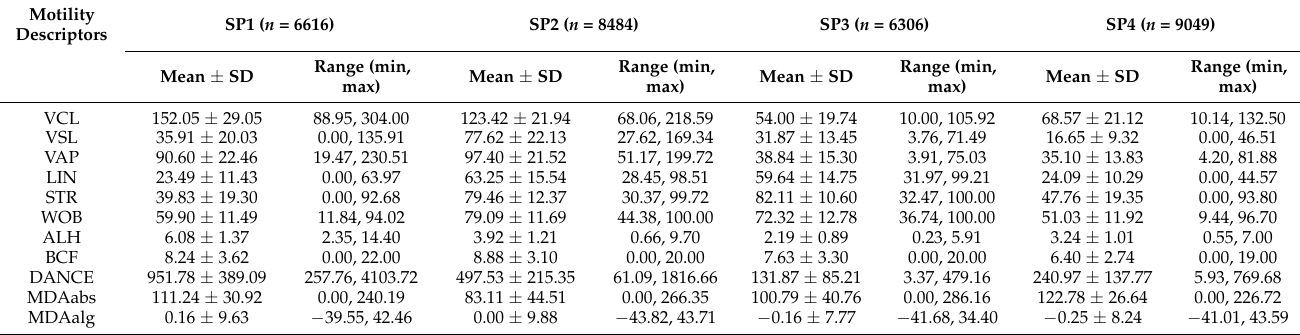
Table 1. Mean and ranges of different motility descriptors (curvilinear velocity (VCL, µ m/s), straight-line velocity (VSL, µ m/s), average path velocity (VAP, µ m/s), percentage of linearity (LIN, %), percentage of straightness (STR, %), percentage of oscillation (WOB, %), lateral head displacement (ALH, µ m), frequency of head displacement (BCF, Hz), DANCE (VCL x ALH, µ m 2 /s)), Absolute angular mean displacement (MDA-Abs, Angular degrees) and Algebraic angular mean displacement (MDA-Alg, Angular degrees)) in the identified motile sperm